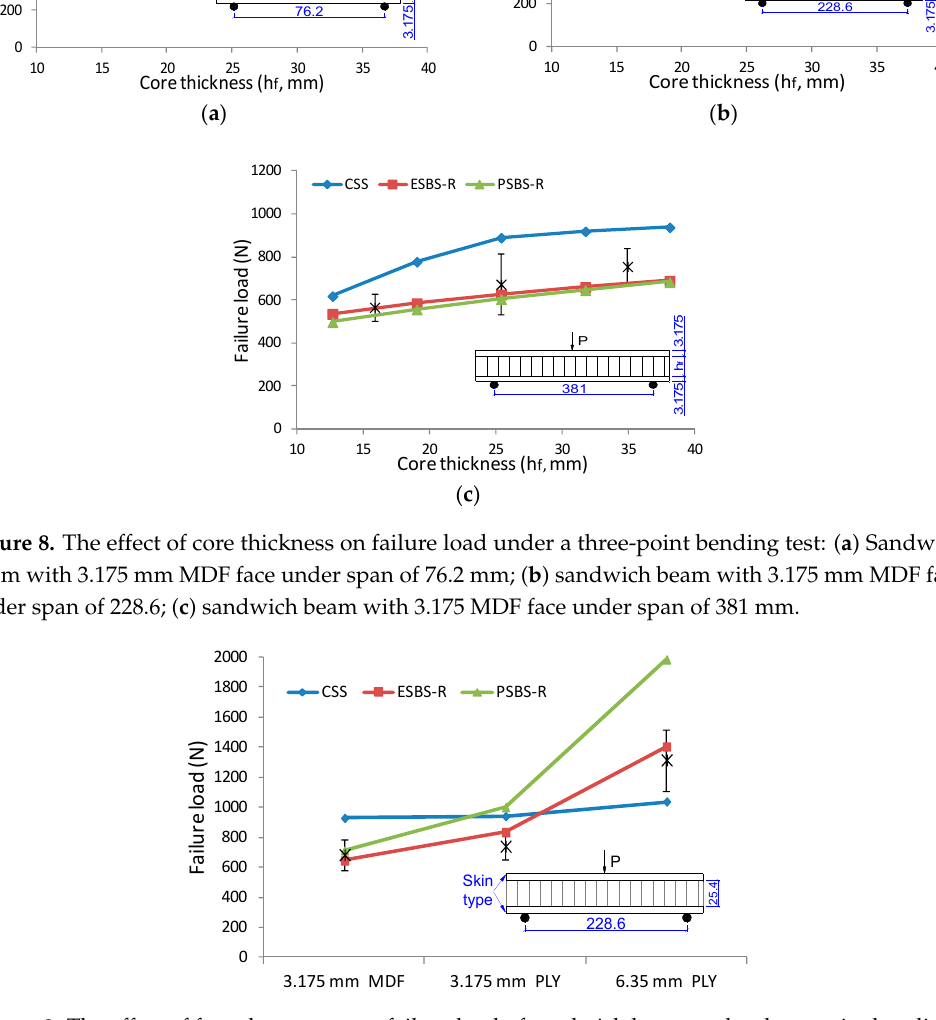
Figure 9. The effect of face sheets type on failure load of sandwich beam under three-point